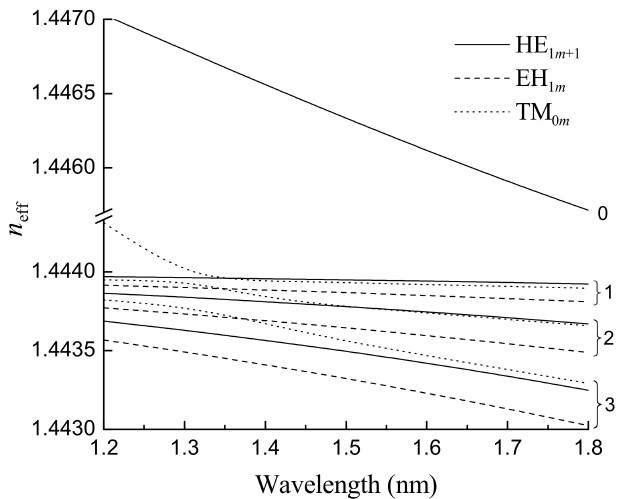
Figure 1. Dependences effective RI of the core mode and some cladding modes on wavelength. Numbering of the curves indicate the radial modal number m . Reprinted from